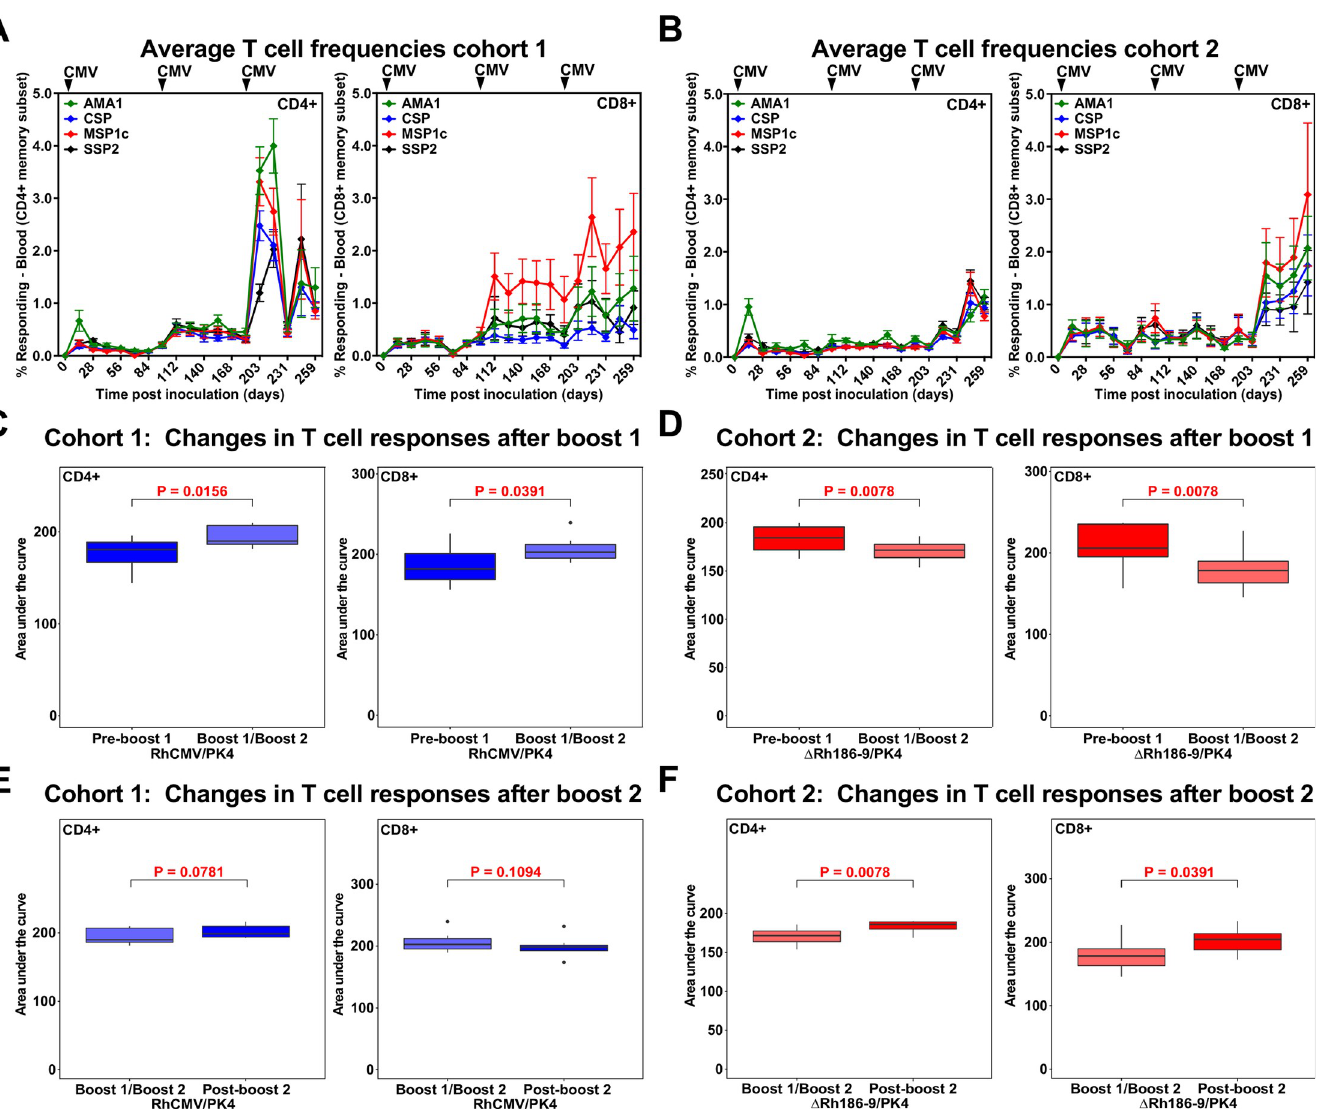
Fig 3. Impact of boosting on T cell responses elicited by RhCMV/PK4 and Δ Rh186-9/PK4. ( A, B) Average frequencies of T cell responses to each of the antigens in cohort 1 (A) or cohort 2 (B) over time. (C-F) Impact of boosting on T cell responses. Statistical analysis of T cell response magnitudes, as determined by measuring the areas under the log10 curve (AUC) of T cell frequencies in each individual RM to all antigens determined by ICS. The boxplots show the median (horizontal line), interquartile range (shaded box), and range (whiskers and outlier points) of the total T cell responses to all antigens. Statistical significance was determined by Wilcoxon test. (C, D) Comparison of the AUC prior to the 1 st boost and between boost 1 and 2 within cohort 1 (C) or cohort 2 (D). (E, F) Comparison of the AUC between boost 1 and 2 versus post-boost 2 within cohort 1 (E) or cohort 2 (D) over 91 days between boosts and for 84 days post boost